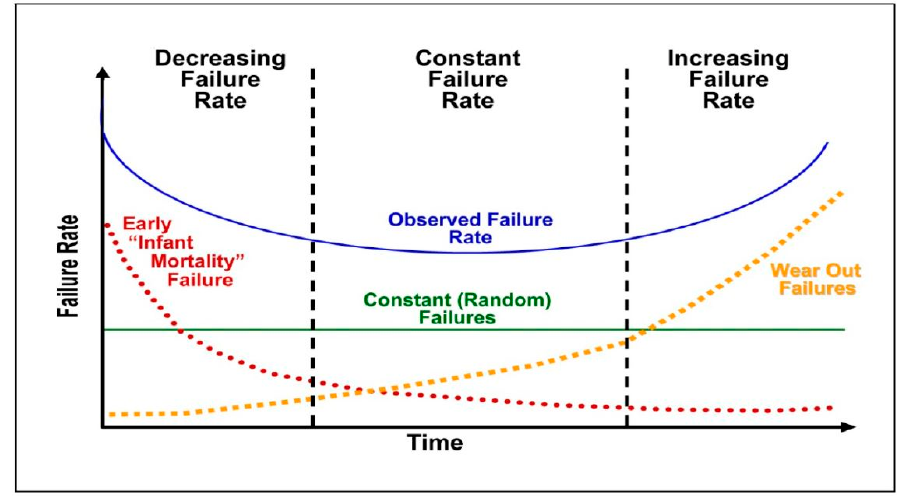
Figure 1. Bathtub curve—“reliability passport” of an electronic product.